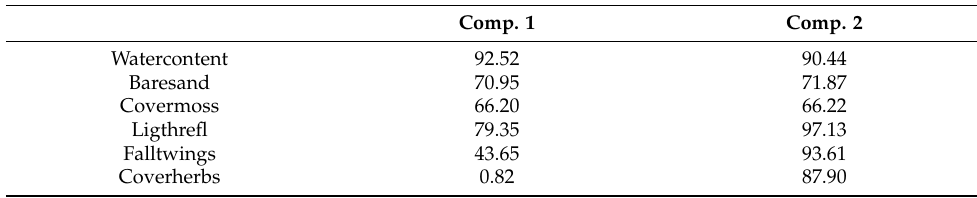
Table 6. Qualities of the